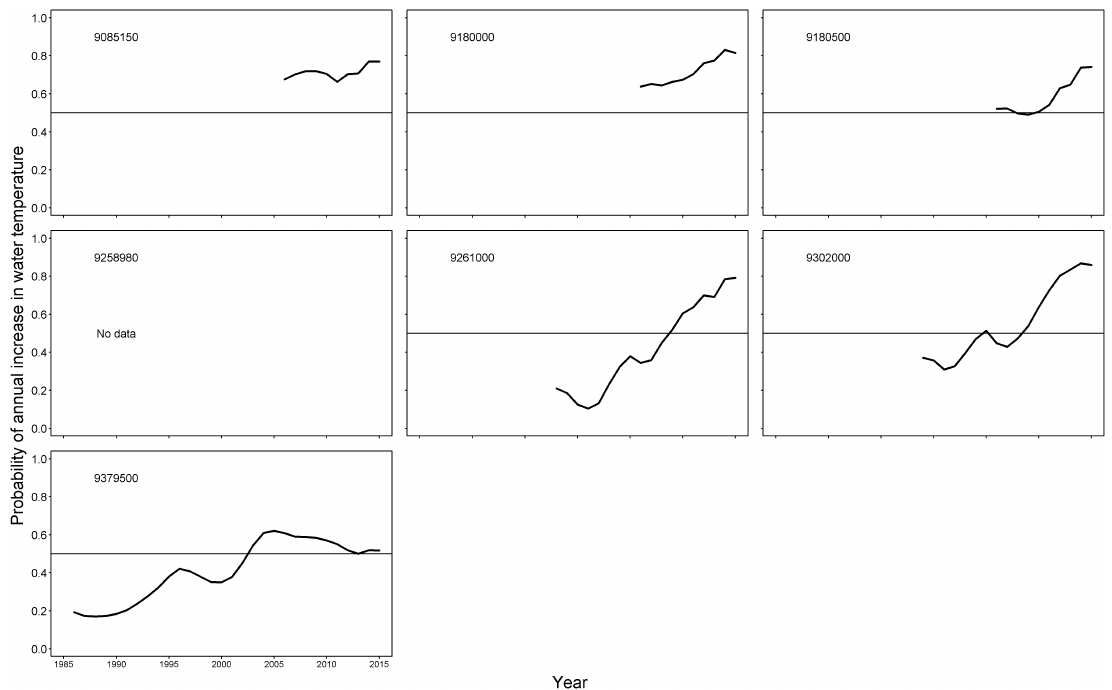
Figure 7. Annual probabilities of an increase in winter river water temperature for sites located in the Upper Colorado River Basin (see Figure 1 for the site map). Numerical codes on each panel correspond to the U.S. Geological Survey gauge